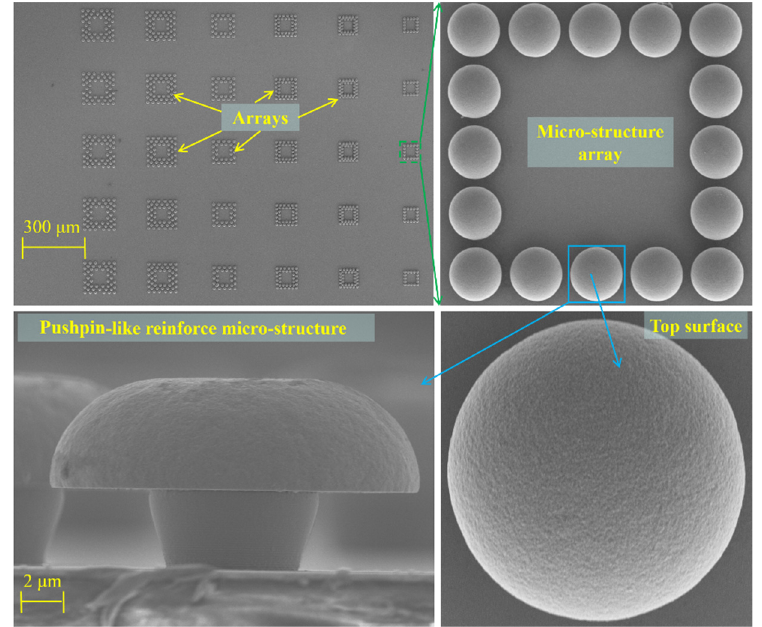
Figure 9. One kind of pushpin-like microstructure profile characterized by SEM.